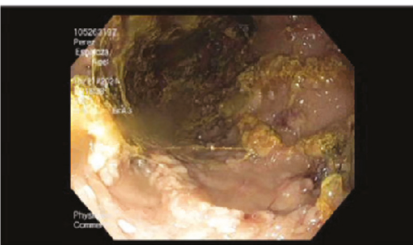
Figure 2: Esophagogastroduodenoscopy of gastric mucosa. The gastric body reveals active areas of inflammation. Image Credit: MichaelSciarra.